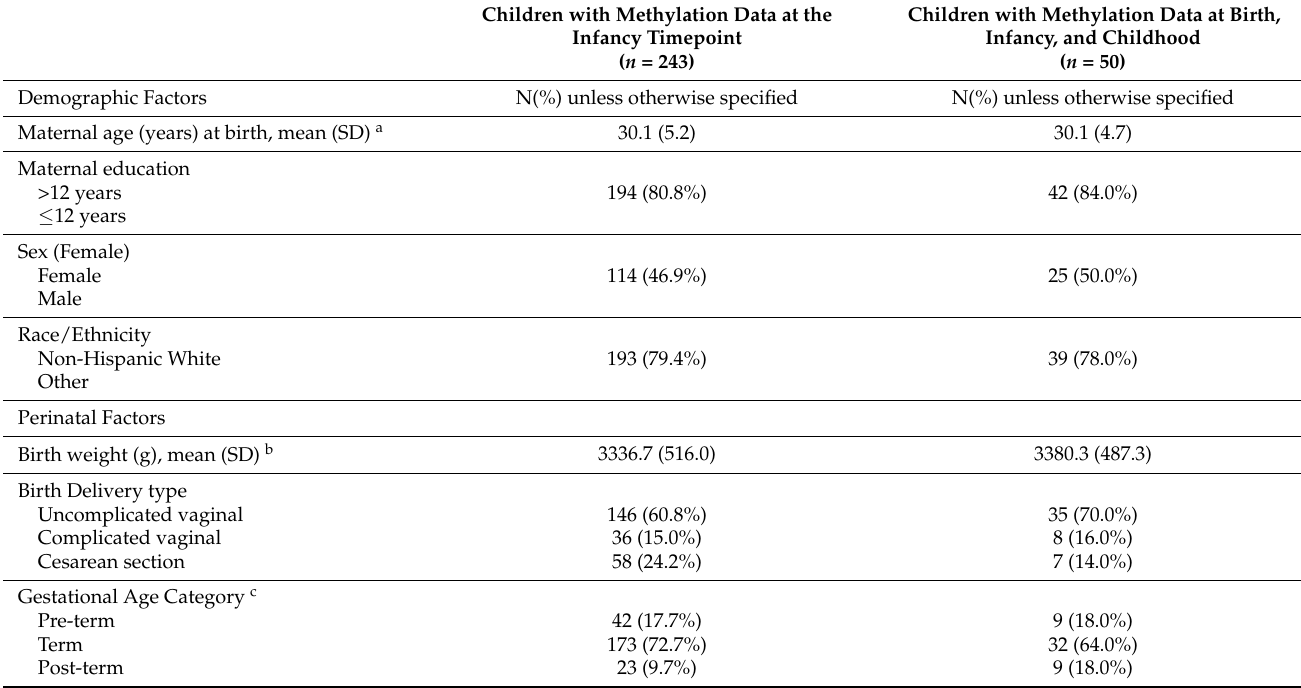
Table 1. Demographic and perinatal characteristics of the children that had methylation data at the different timepoints. Children with Methylation Data at the Infancy Timepoint